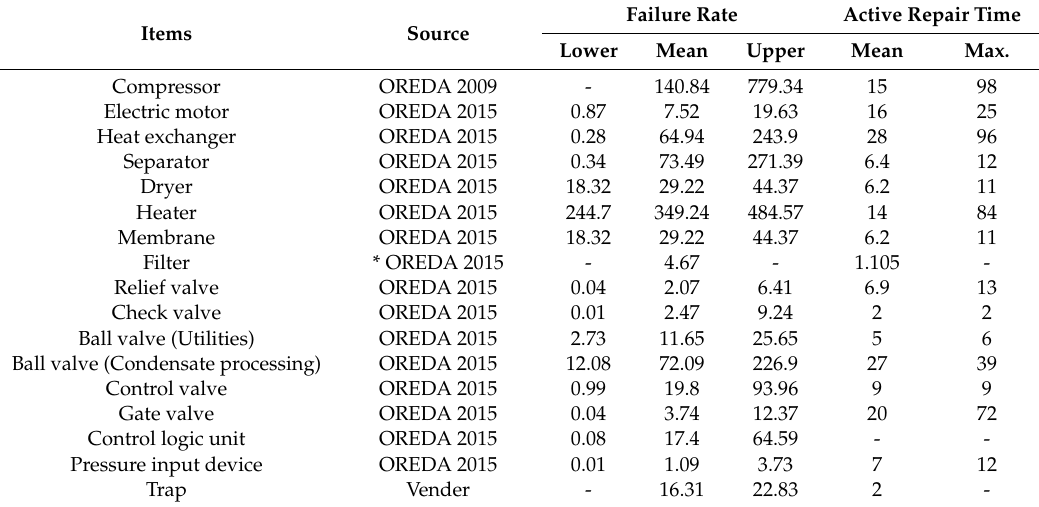
Table 2. Reliability and maintainability data for air and nitrogen system.